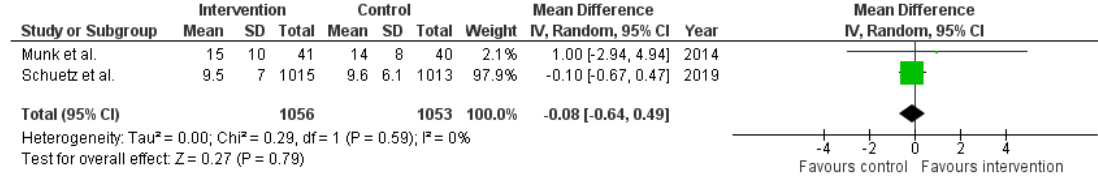
Figure 2. Meta ‐ analysis of randomised controlled trials reporting length of stay [31,38]. Figure 2. Meta-analysis of randomised controlled trials reporting length of stay